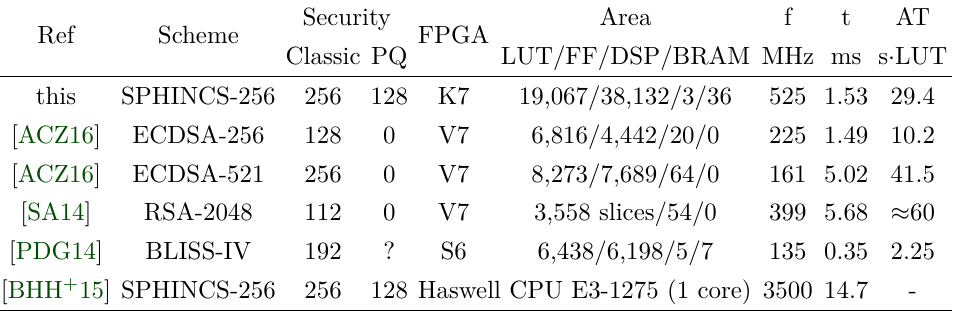
Table 4: Our SPHINCS accelerator is more efficient than today’s widely used RSA. Security Area f t AT Ref Scheme FPGA Classic PQ LUT/FF/DSP/BRAM MHz ms s · LUT this SPHINCS-256 256 128 K7 19,067/38,132/3/36